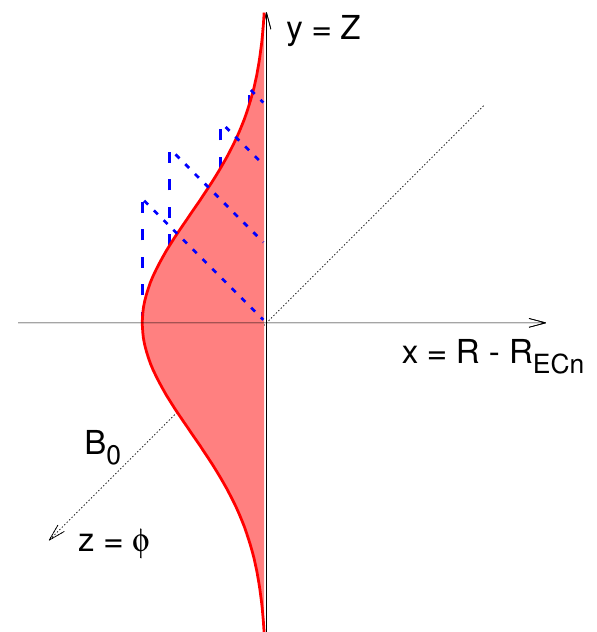
Figure 10. Region R x y in ( x ,y ) plane where nonlinear EC in- teraction takes place (red filled region). Note that the picture is expanded in x direction. The blue dashed lines are the energy profiles for di ff erent values of the y